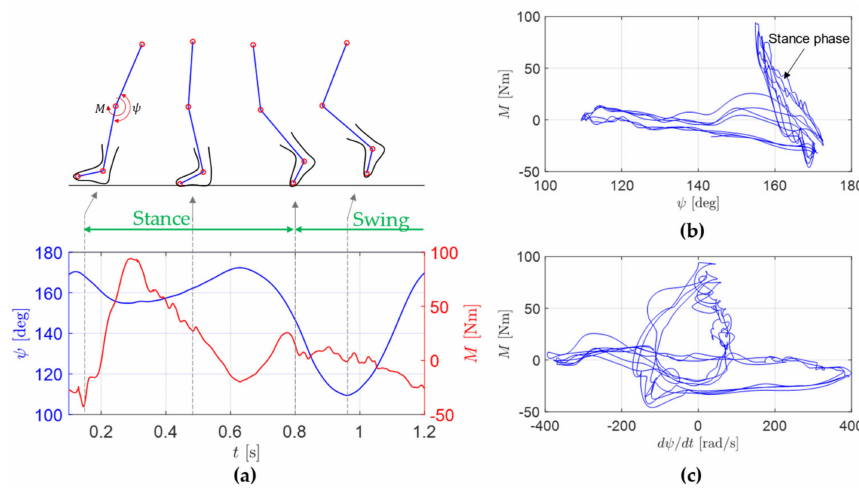
Figure 4. ( a ) Knee angle and torque over one gait cycle; ( b ) knee torque vs. knee angle over multiple gait cycles; ( c ) knee torque vs. knee angular speed over multiple gait cycles.